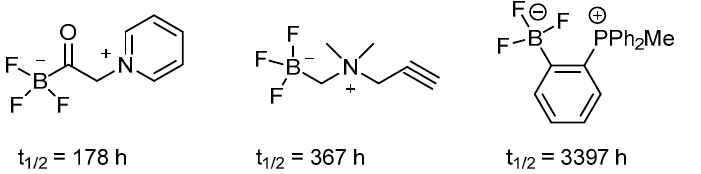
Figure 3. Trifluoroborates showing stability via electron-withdrawing contribution on an arene ring [70].